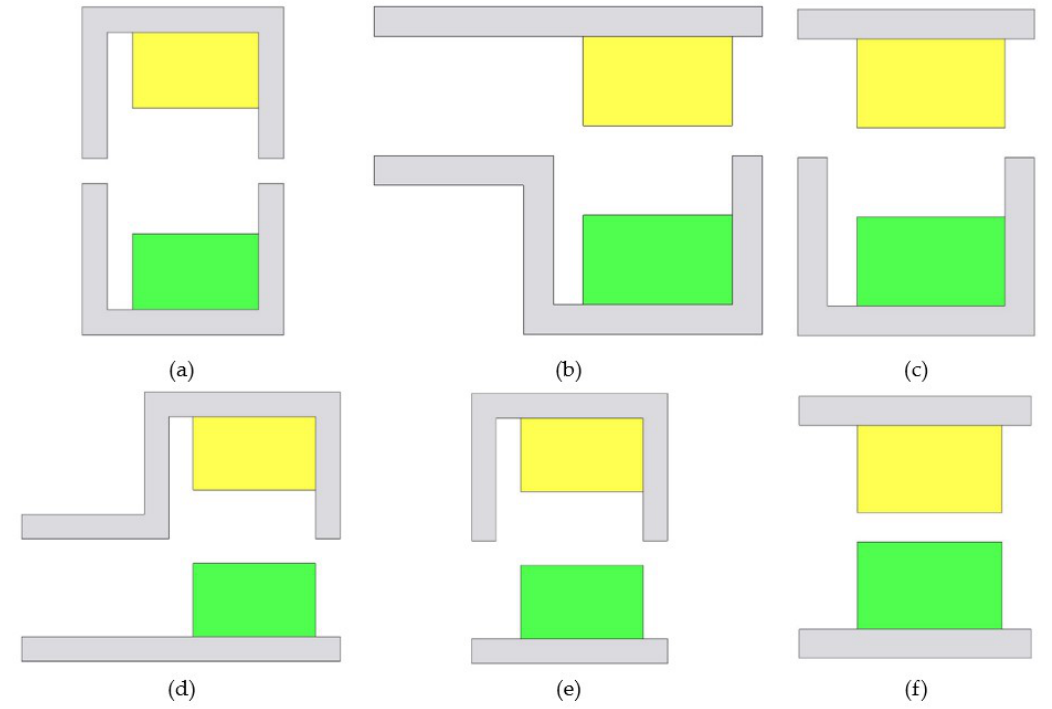
Figure 3. Half models (left) of CIPT. ( a ) EE shape without legs. ( b ) EI shape with legs. ( c ) EI shape without legs. ( d ) IE shape with legs. ( e ) IE shape without legs. ( f ) II